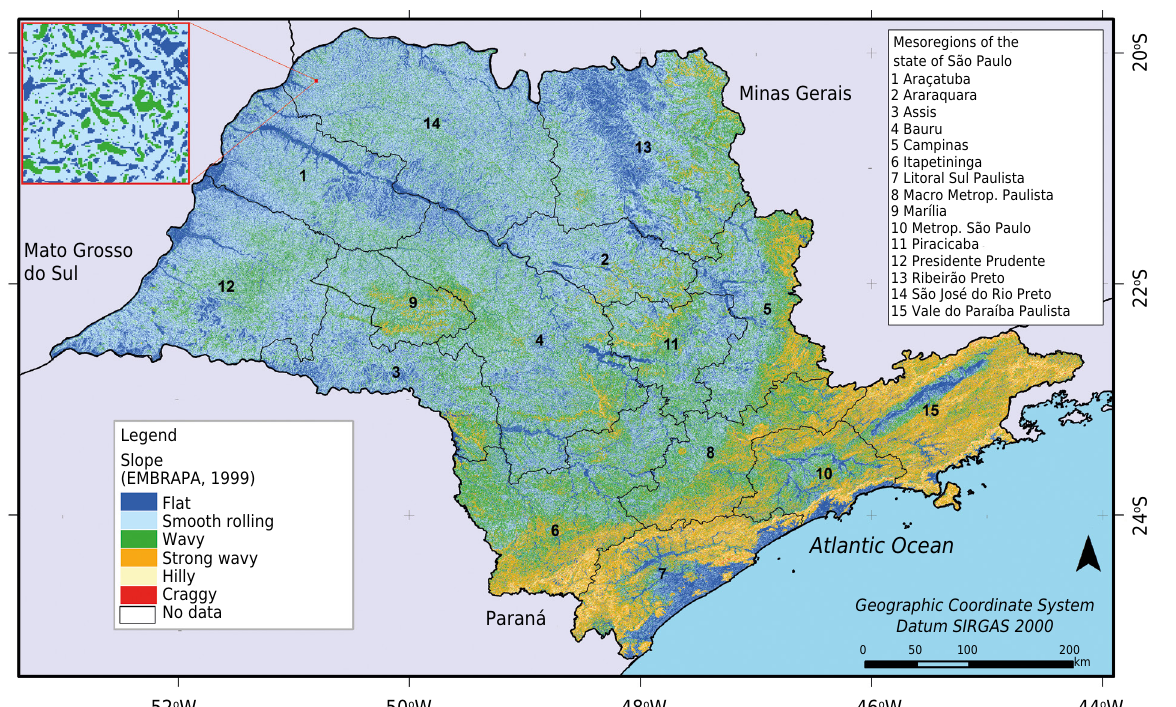
Figure 7. Slope map based on Embrapa